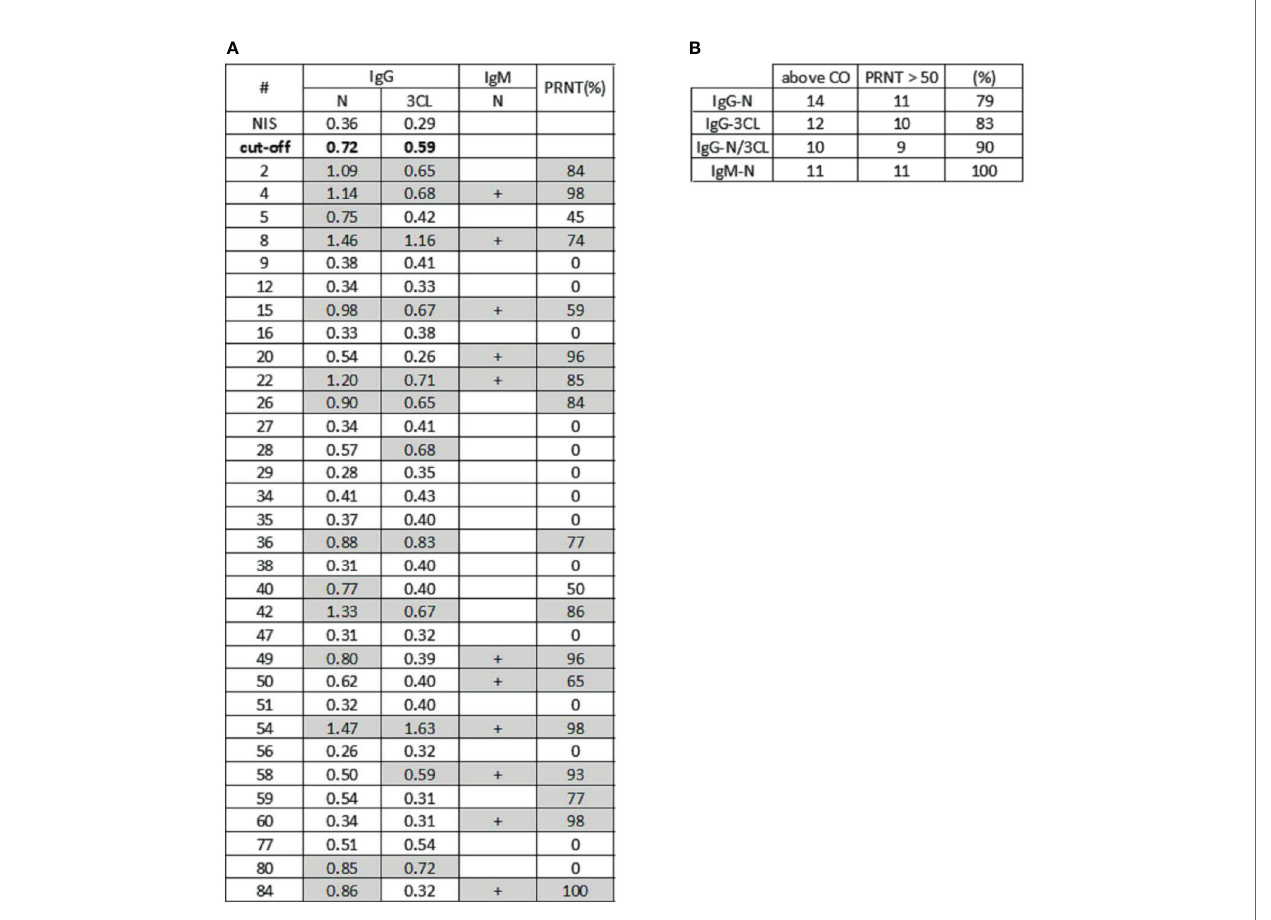
FIGURE 5 | Serological pro fi ling and virus neutralization. (A) The table shows absorbance signal for antiviral IgG reactive to N protein and 3CL protein by ELISA assay, IgM detection for N protein by LFA assay, and plaque reduction neutralization test (PRNT). Samples with absorbance signal above neutralization cutoff (twice NIS absorbance signal) for both antigens and samples with PRNT higher than 50% are highlighted in gray. (B) The table shows samples that exhibited high signal for antiviral antibodies to N protein (N), 3CL protease (3CL) and simultaneously (N and 3CL protein), in association to PRNT. In the “ above CO ” column, we have high IgG signal samples above the IgG positive cutoff (CO). The column PRNT>50 shows samples with neutralization activity higher than 50%. The last column shows the percentage of high neutralization samples that also have IgG signal above the cutoff, or IgM